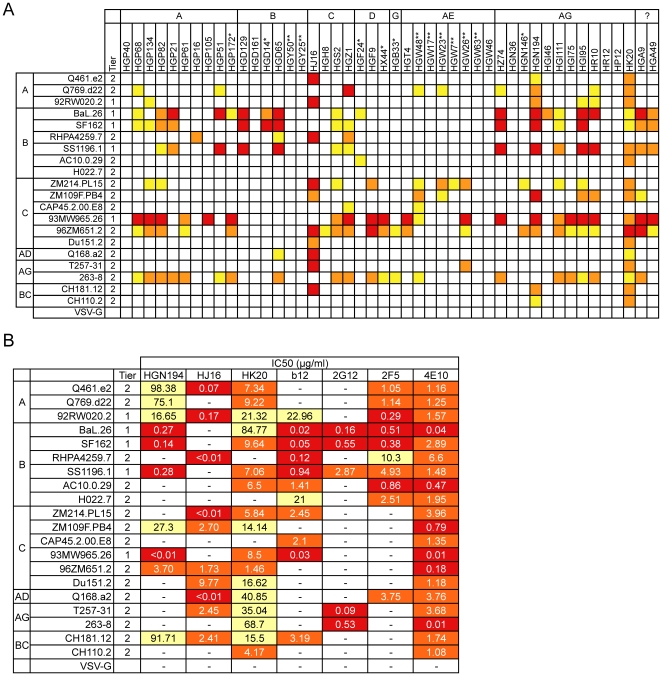
Neutralization of 20 HIV-1 isolates in HOS.CD4-R5 cells by a panel of human mAbs.(A) 46 mAbs (upper rows) were purified and tested in triplicates at a fixed concentration (100 µg/ml; *50 µg/ml and **25 µg/ml) for their capacity to neutralize 20 HIV-1 pseudoviruses (left columns) representing 6 different clades and both Tier-1 and Tier-2 isolates using HOS.CD4-R5 as target cells. Indicated is also the donor's HIV-1 clade. White, neutralization below 50%; yellow, 51–69%; orange, 70–89% and red, 90–100% neutralization. VSV-G pseudotyped HIV-1 was also tested as a negative control. (B) HK20, HGN194 and HJ16 were tested in parallel with b12, 2G12, 2F5 and 4E10 for their capacity to neutralize 20 HIV-1 pseudoviruses representing 6 different clades and both Tier-1 and Tier-2 isolates using HOS-CD4.R5 cells as in (A). Shown are IC50 values in µg/ml. -, indicates IC50 values >100 µg/ml.